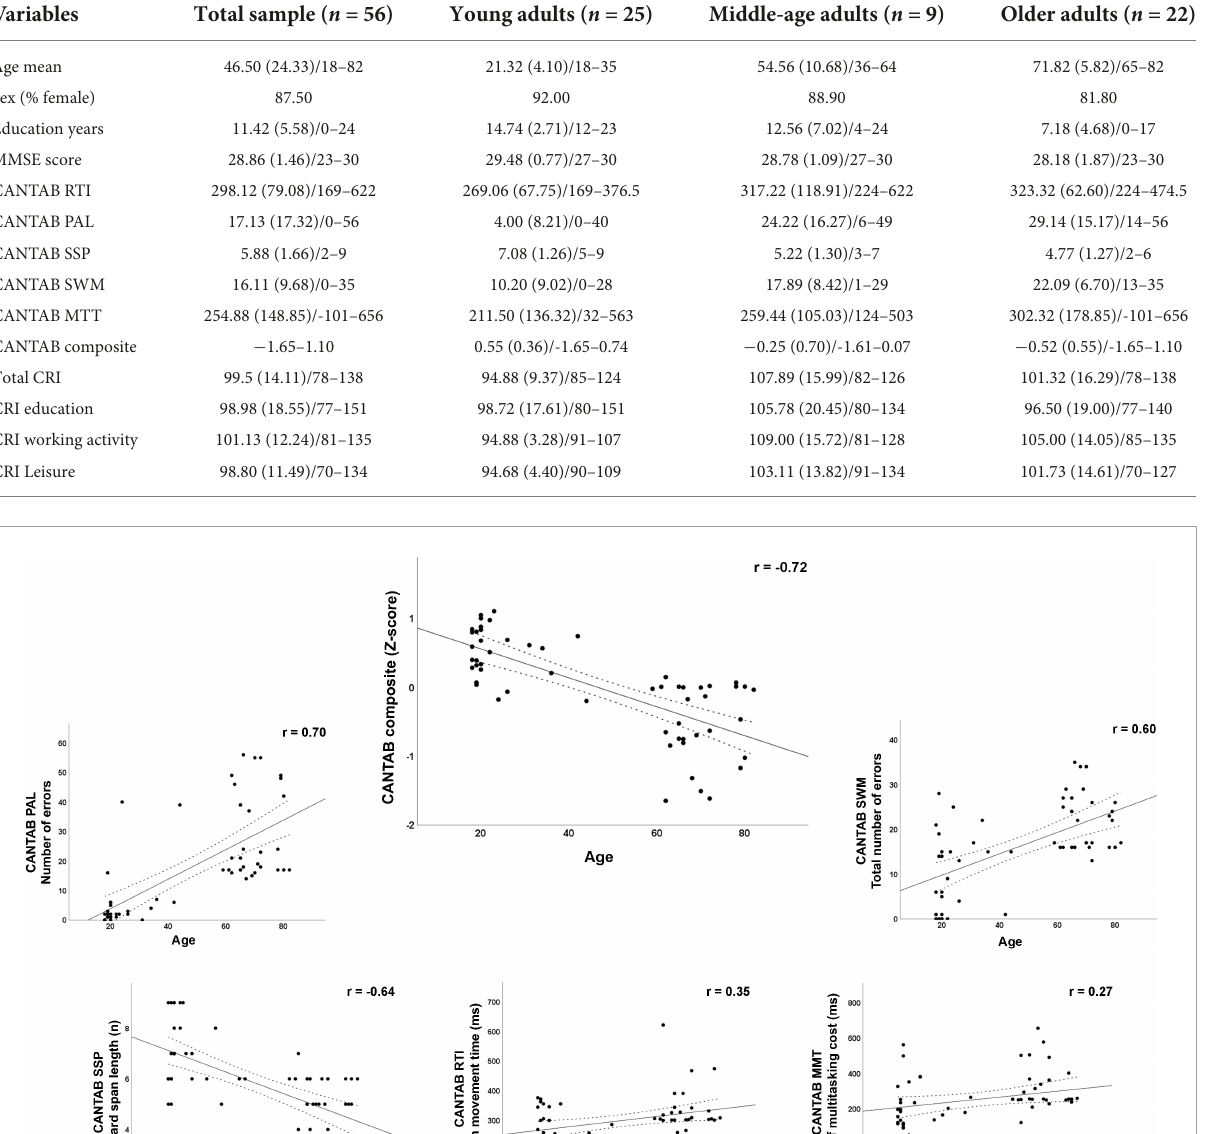
TABLE 1 Demographic and cognitive characteristics [mean (SD)/ranges or %] for the total sample and the three groups of age.